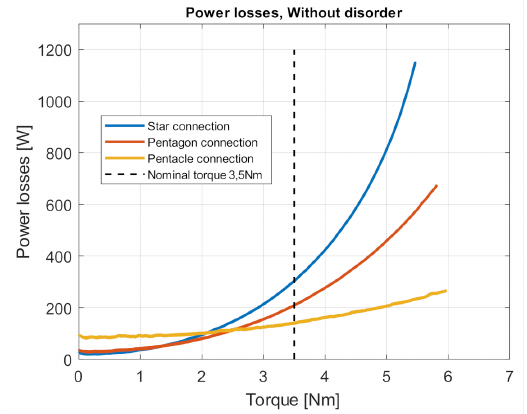
Figure 14. Motor losses, fault-free condition, U IN = 5 × 230 V, 50